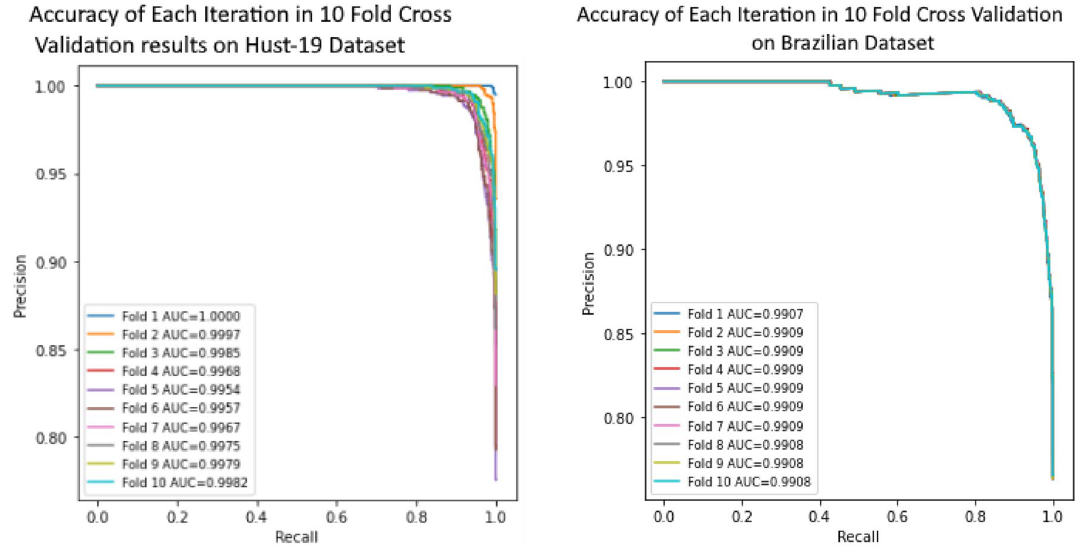
Figure 11. ( a ) 10 Fold Cross Validation results on Hust-19 Dataset ( b ) 10 Fold Cross Validation results on Brazilian